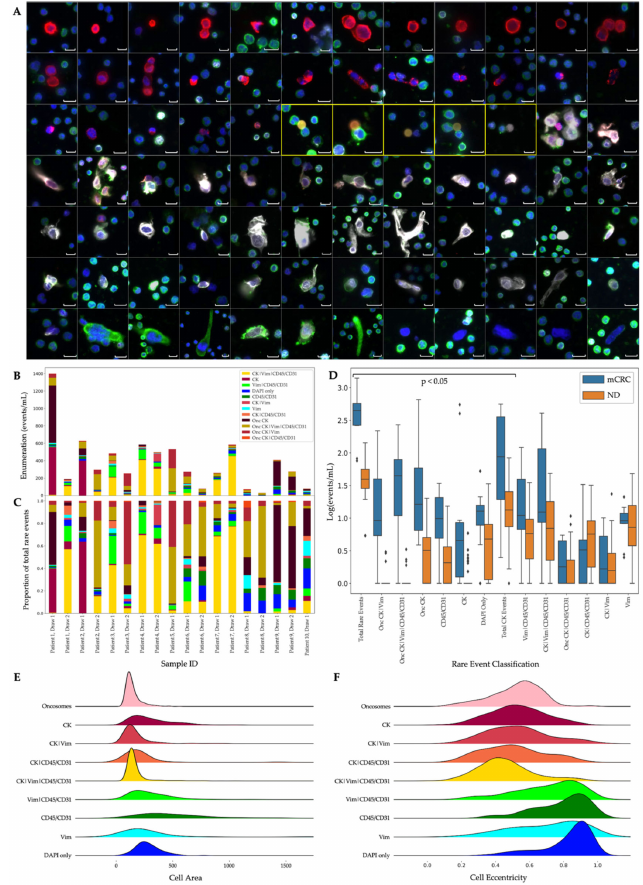
Figure 1. Landscape-stained samples analyzed by OCULAR. ( A ) Representative gallery from the metastatic colorectal cancer (mCRC) cohort showing the morphological heterogeneity of the detected rare events. DAPI: blue, cytokeratin (CK): red, Vim: white, CD45/CD31: green. Events from each of the 10 patients are represented in the gallery. The five oncosomes displayed are bordered by yellow boxes. Events are ordered by decreasing CK signal intensity. Images taken at 400 × magnification. Scale bars represent 10 µ m. ( B ) Rare-event enumeration (events/mL) and ( C ) frequency (%) per patient and draw. ( D ) Enumeration comparison of Draw 1 mCRC and normal donor samples ordered by statistical significance. Symbols indicate outliers. The first 8 classifications from the left